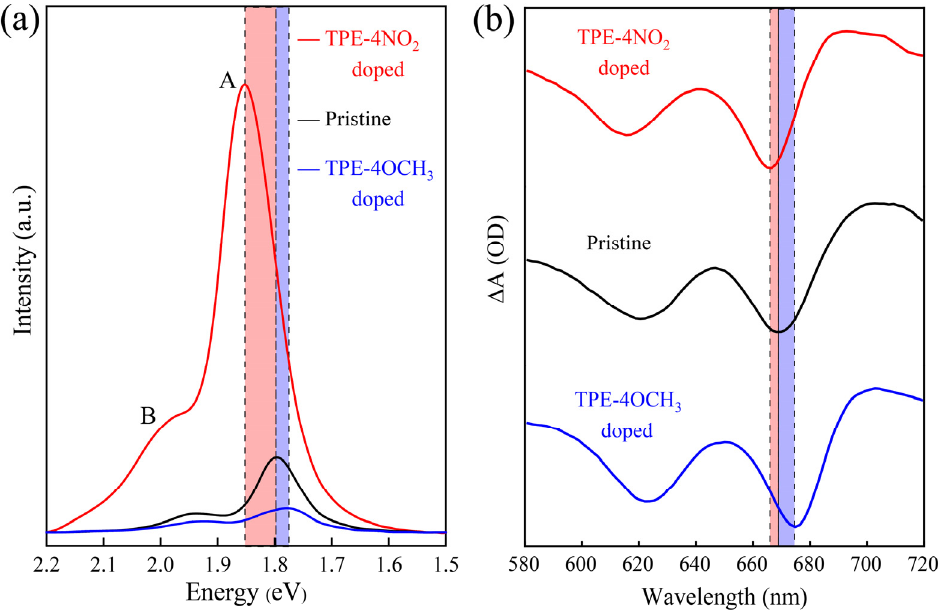
Figure 2. PL spectra ( a ) and transient absorption spectra ( b ) of pristine and doped MoS 2 samples.